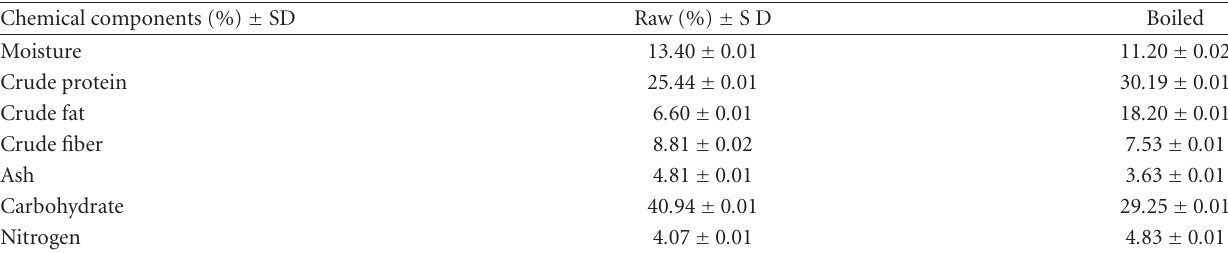
Table 1: Proximate composition (mean of 5 replicates) of Parkia biglobosa seeds.